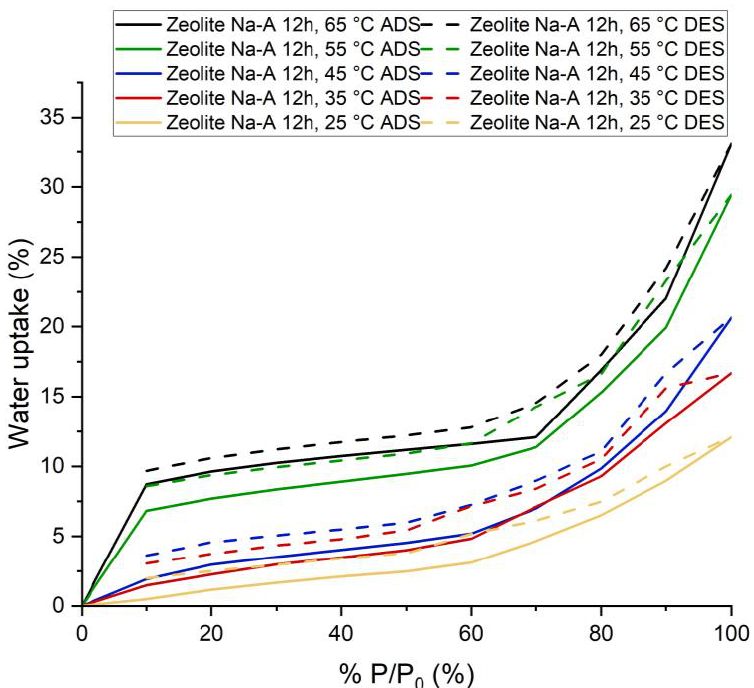
Figure 6. Adsorption and Desorption Isotherms for Silica Gel (at five process temperatures 25, 35, 45, 55 and 60 °C.